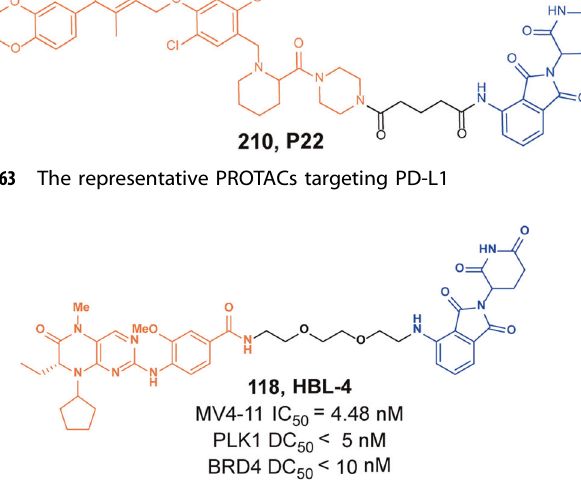
Fig. 64 The representative PROTAC targeting